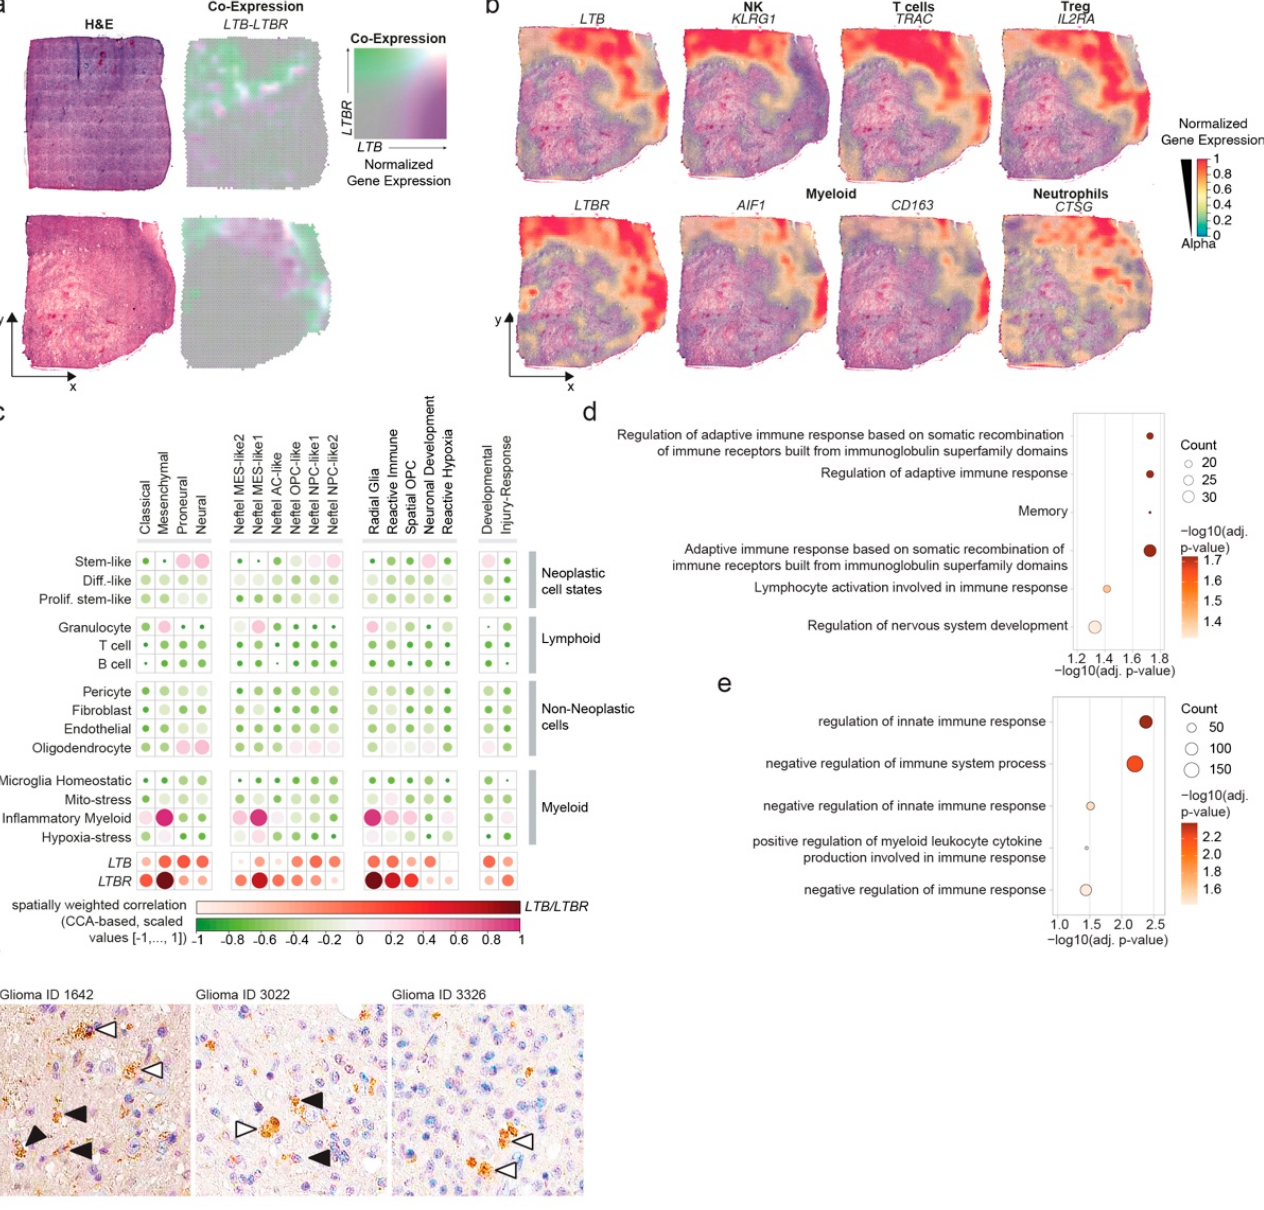
Figure 5. LTB expression is spatially associated with lymphoid cell and neurodevelopmental genes and clinically associated with poor prognosis. ( a ) H&E images of two independent glioblastoma samples analyzed using 10X Visium from a published dataset [10]. Spatial co-expression of LTB and LTBR is color-coded. ( b ) The normalized spatial gene expression of the indicated genes and the cell types that these genes are enriched in is superimposed with the bottom case from figure panel a. ( c ) Dot plot visualizing the spatially weighted correlation analysis between the expression of the LTB and LTBR with glioblastoma-associated gene sets. ( d ) Dot plot indicating the gene ontology terms enriched in dots with LTB expression. ( e ) Dot plot indicating the immune-associated gene ontology terms enriched in dots with LTBR expression. ( f ) Representative images of LTBR immunohistochemistry from the Human Protein Atlas. The sample IDs are presented above the images. Filled arrowheads indicate ramified microglia-like cells; empty arrowheads indicate cells with foamy macrophage-like morphology.